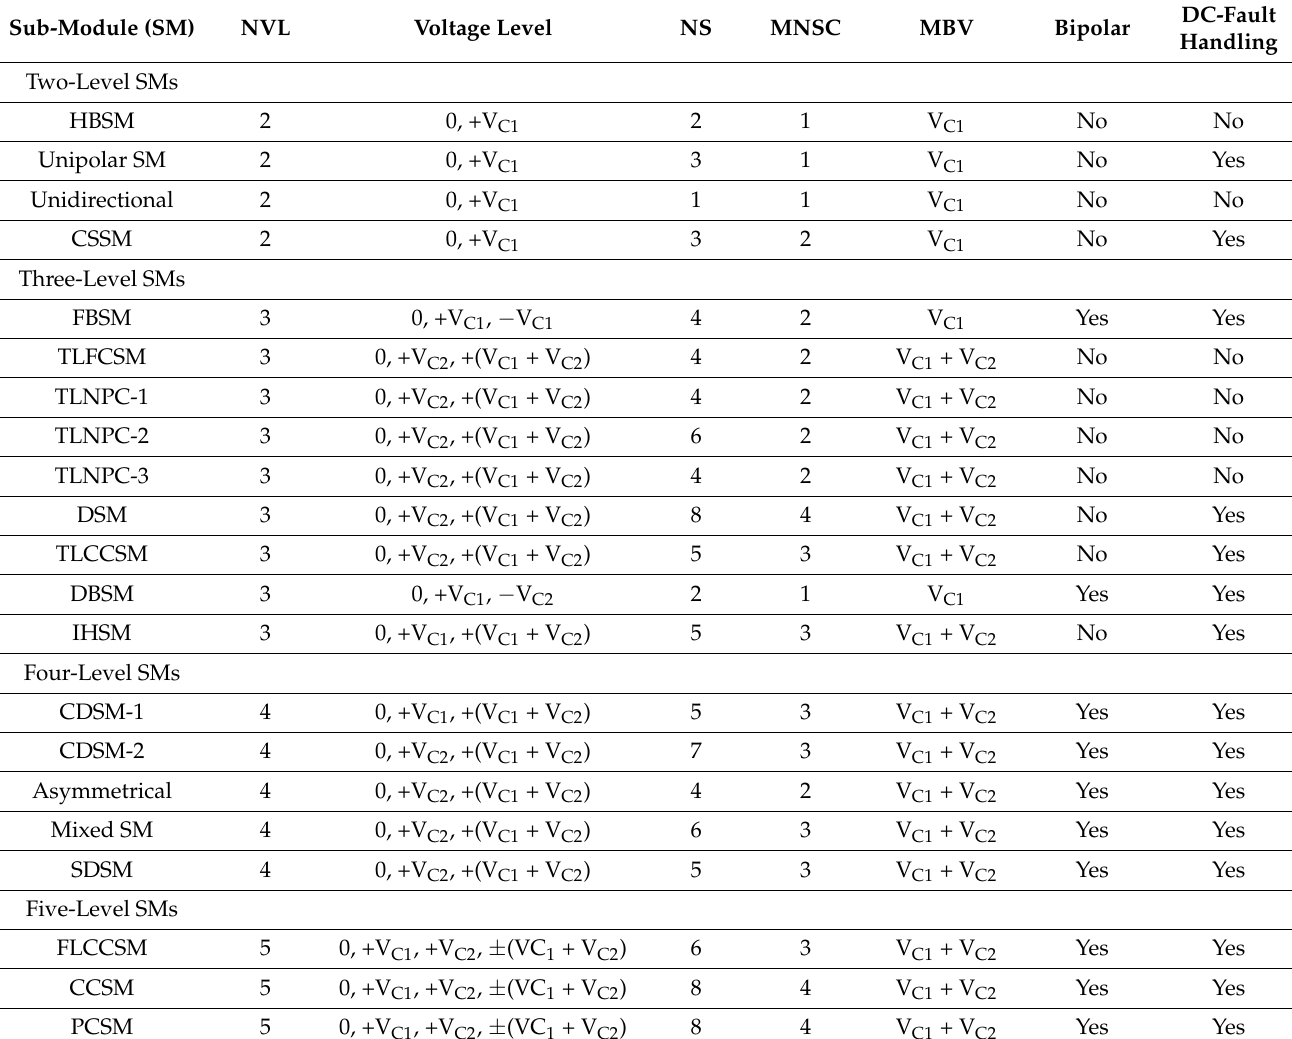
Table 1. Comparison of different submodules